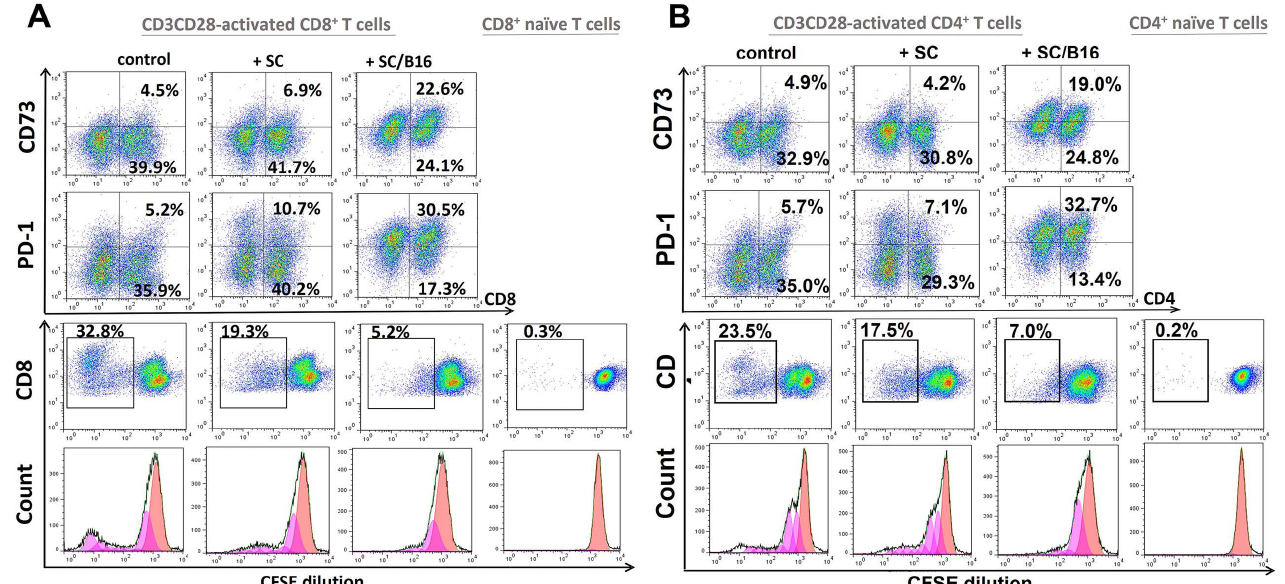
Figure 1. Tumor-activated Schwann cells induced exhaustion of T cells. Adult SC were isolated from the sciatic nerve of C57BL/6 mice, cultured and purified as described in M&M. SC were then co-cultured with medium (SC) or with B16-conditioned medium (10% v / v ) for 48 h and washed. Then, control and melanoma-pretreated SC were mixed with SFSE-labeled splenic T cells that were activated by CD3-CD28-coated beads for 24 h. After 5 days, expression of CD73 and PD-1 on CD8+ ( A ) and CD4+ ( B ) T cells was evaluated by flow cytometry. Gating strategy was based on the initial selection of CD3+ T cells with the further analysis of CD73 and PD-1 expression on either CD8+ or CD4+ cells. Proliferation of CFSE-labeled T cells was assessed by tracing dye dilution by flow cytometry. Results from a representative experiment are